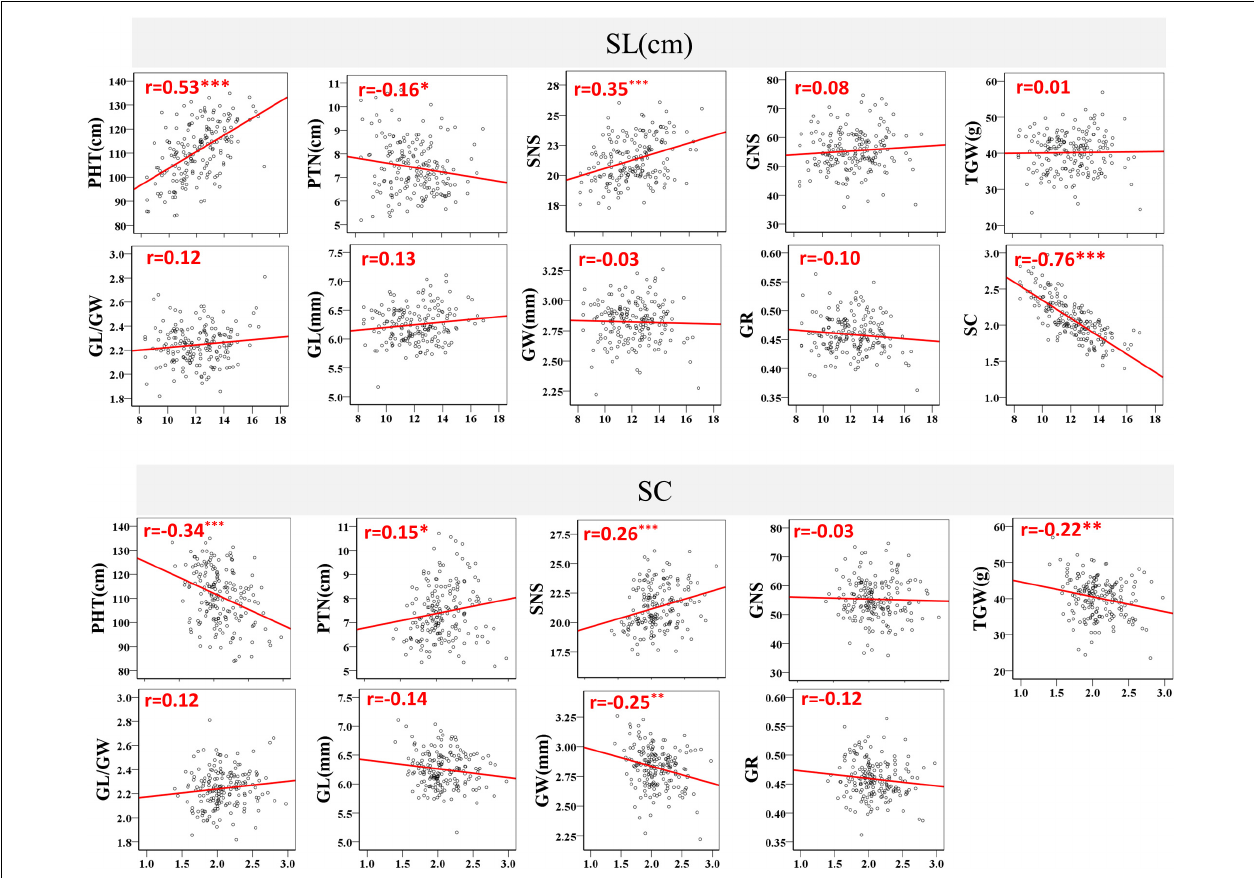
FIGURE 3 | Coefficients of pair-wise Pearson’s correlations between spike compactness (SC), spike length (SL), plant height (PHT), productive tiller number (PTN), spikelet number per spike (SNS), grain number per spike (GNS), thousand-grain weight (TGW), grain width (GW), grain length (GL), GL/GW ratio, and grain roundness (GR) in the BC20 population. ∗ , ∗∗ , and ∗∗∗ represent significance at P < 0.05, P < 0.01, and P < 0.001,